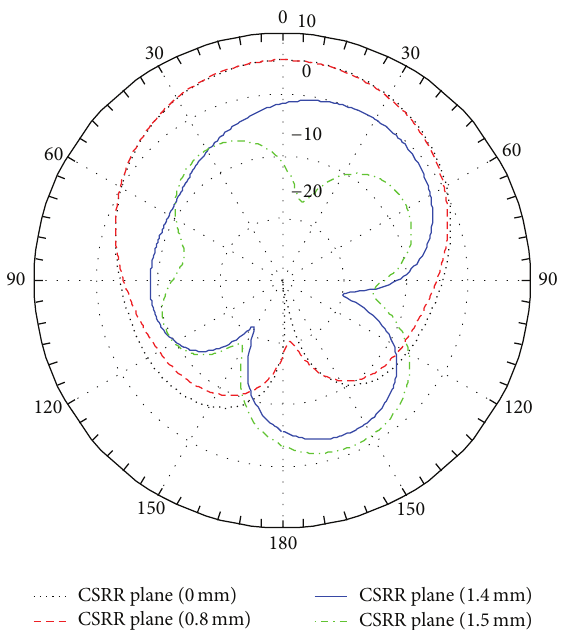
Figure 11: Simulation results for 𝐸 -plane gain of miniaturized patch at different location of CSRR plane moved towards the feed line.